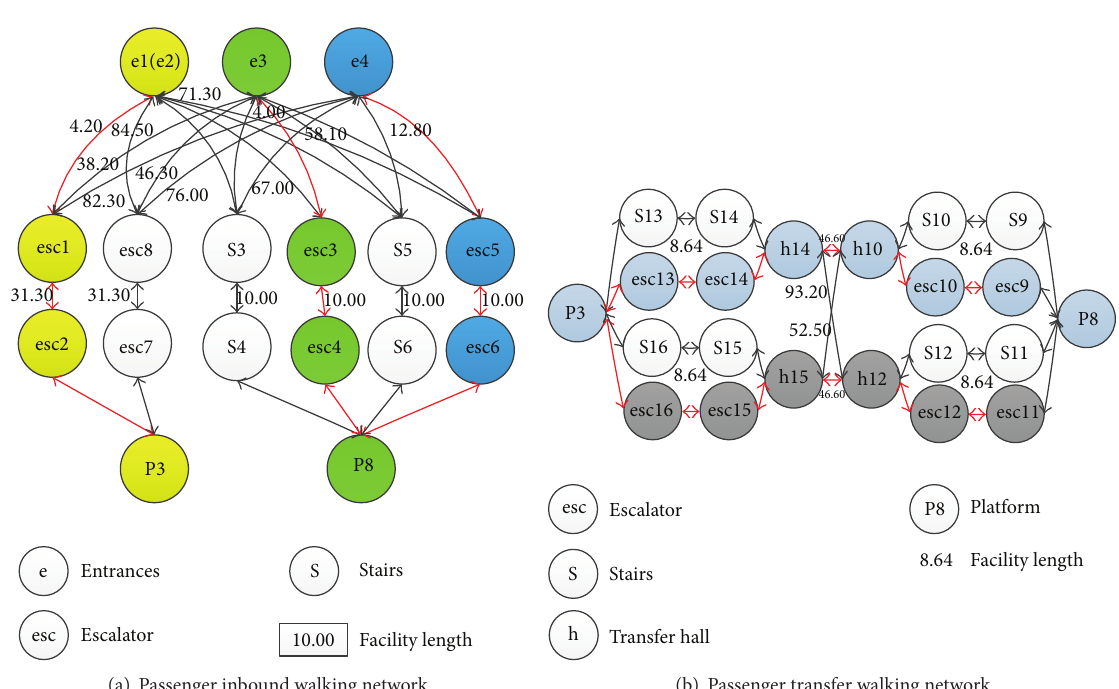
Figure 4: Walking network structure of Kecun